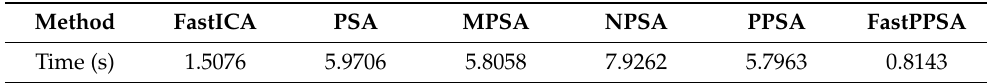
Table 4. Running time evaluation of BSS